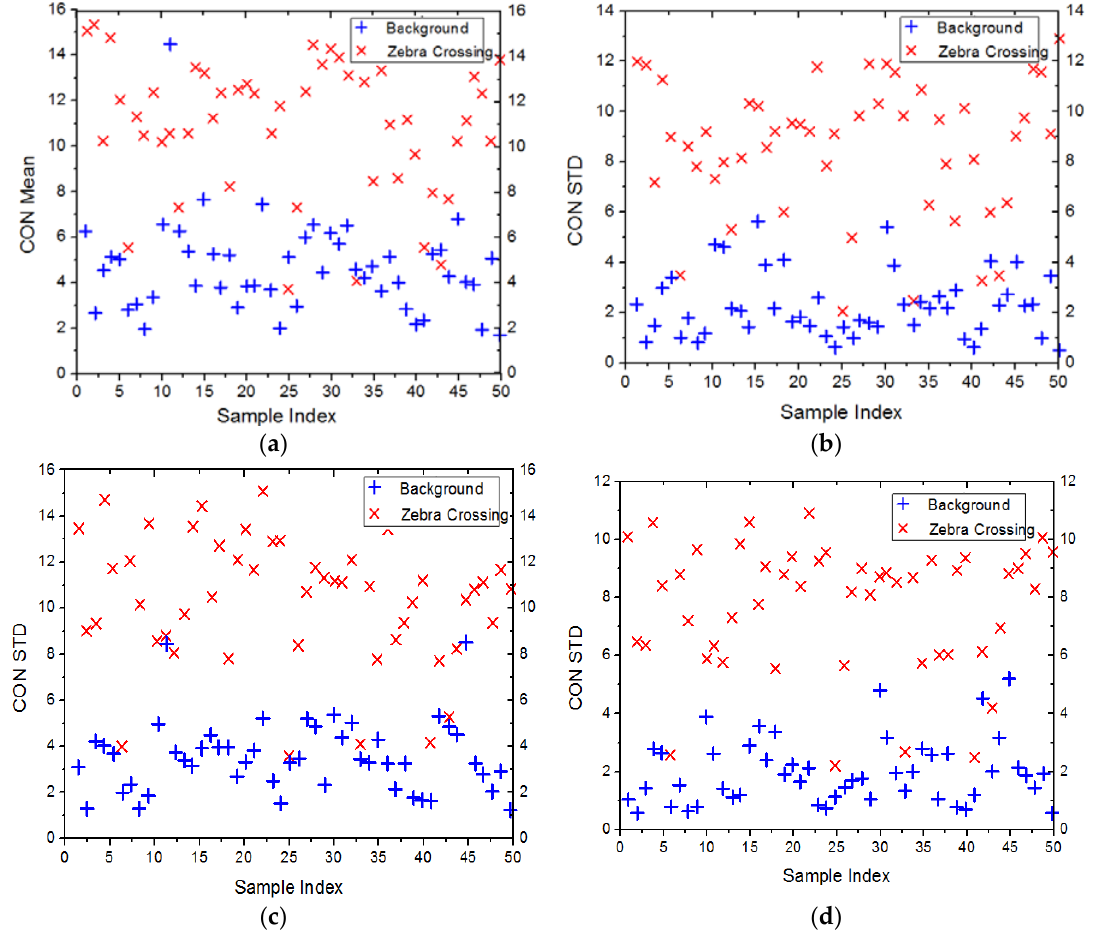
Figure 4. ( a ) Image after enhancement; ( b – f ) Image colored by the absolute value of each DoG layer, which are normalized to the range of 0–255.